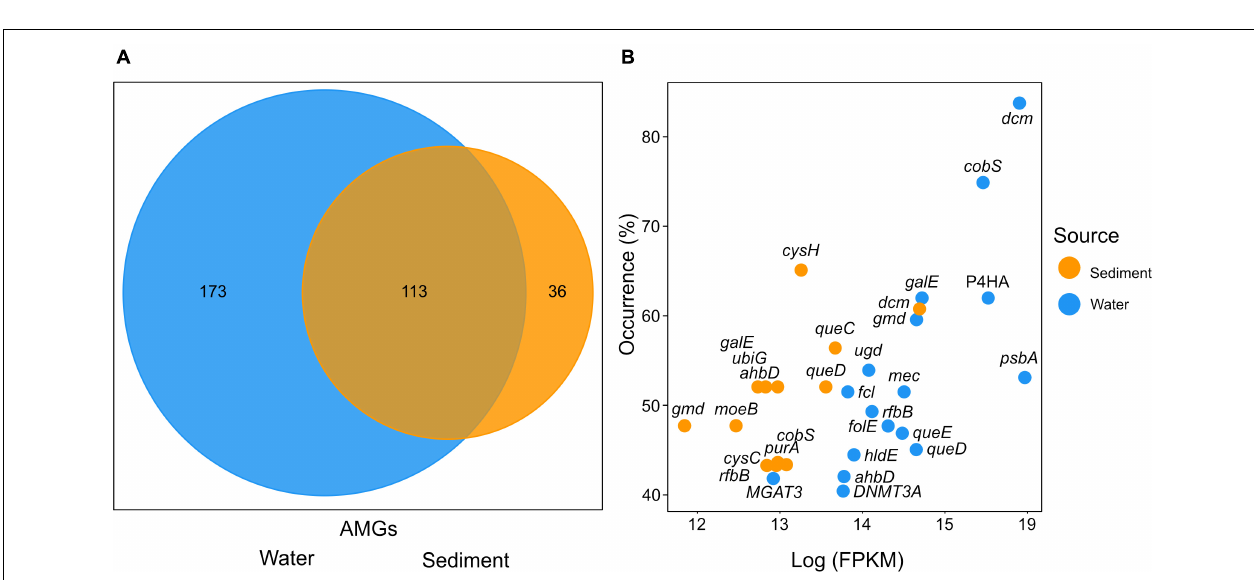
FIGURE 4 | (A) Principal component analysis of beta diversity using Aitchinson distance shows distinct patterns in community composition of sediment and water communities. (B) Shannon alpha diversity of Baltic Sea viral communities in Wilcoxon p -value of 0.7861 indicates no relevant difference in per-sample diversity when comparing species richness of sediment and water communities. (C) Non-metric multidimensional scaling (NMDS) analysis using Bray–Curtis dissimilarity. Vectors of the top nine most abundant families and of environmental factors were fitted to the ordination using the envfit function. A separation of sediment and water stations can be observed along the salinity gradient plotted using the ordisurf function. Envfit vectors indicate a tendency of viruses toward the lysogenic lifestyle in sediment metagenomes and lytic lifestyle in the water columns.